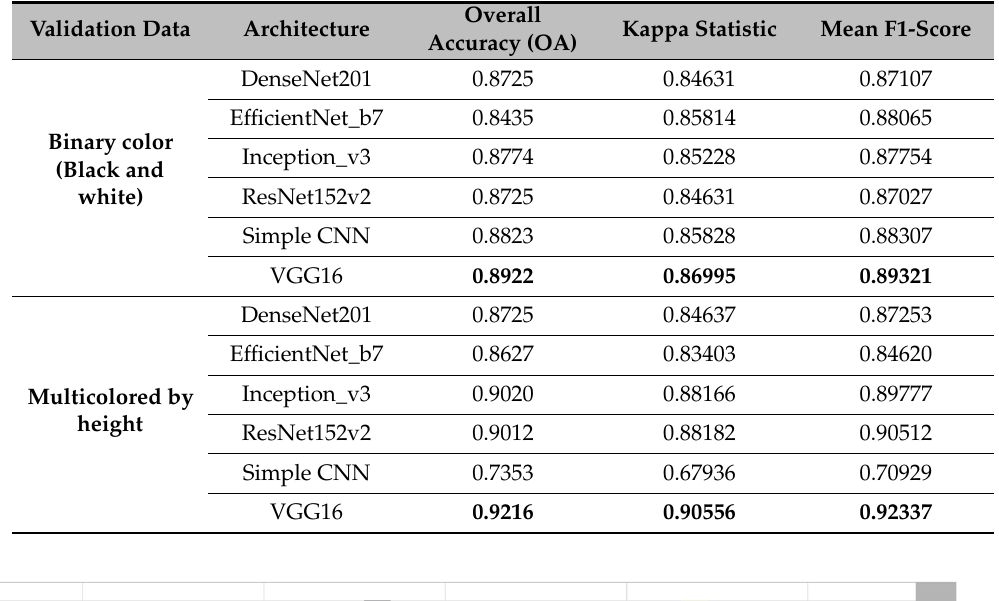
Table 1. Summary of overall accuracy, kappa statistics, and mean F1-score for six models’ approaches within image type (colored by height and black) from the validation dataset. The best results by image type are shown in bold.